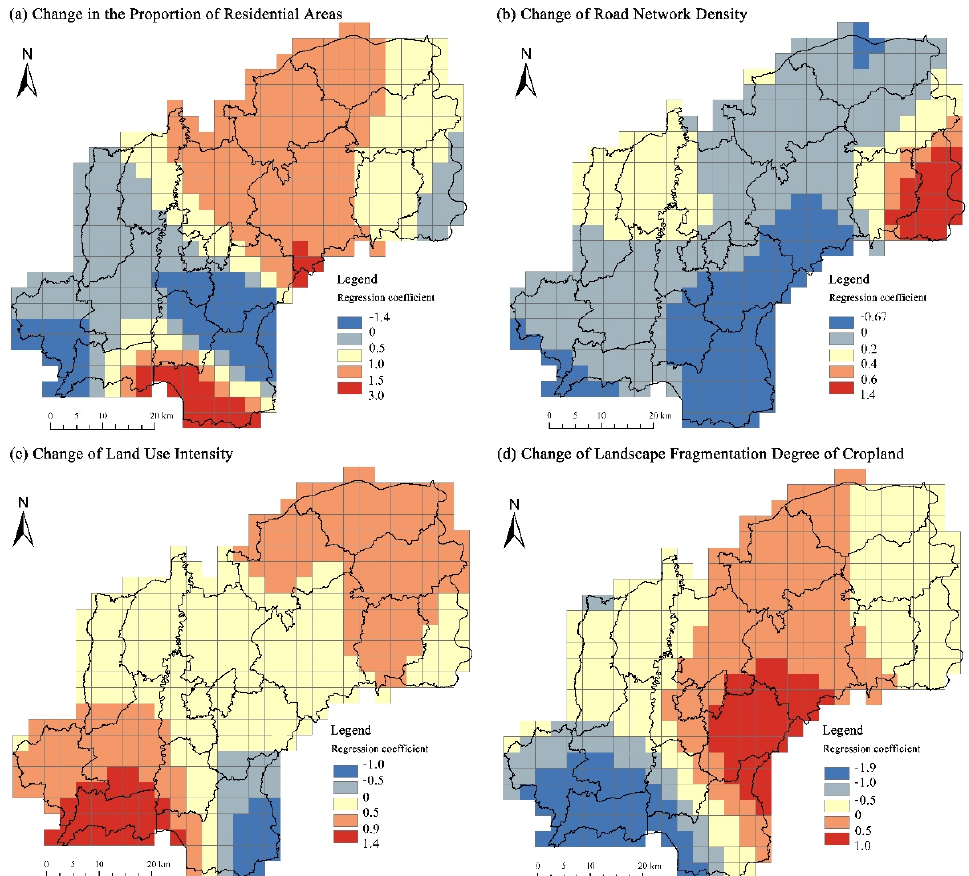
Figure 7. Spatial distribution of regression coefficients of explanatory variables of socioeconomic and land use factors in the GWR model.